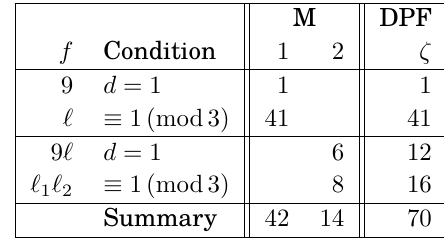
Table 7: Cyclic cubic discriminants d L = f 2 in the range 0 < d L < 2 · 10 5